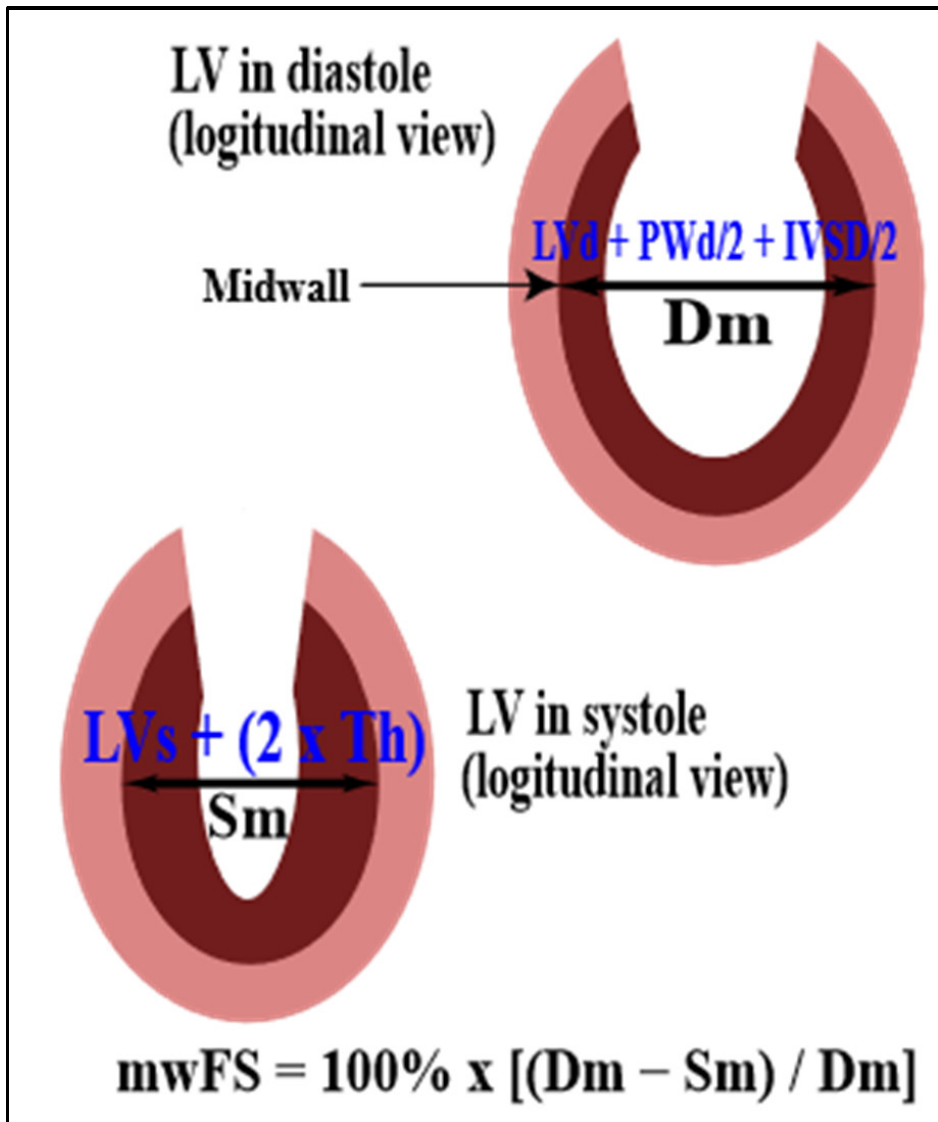
Figure 2. Calculation of LV midwall fractional shortening (mwFS) from LV end-diastolic diameter (Dm) and LV end-systolic diameter (Sm) at the midwall level. IVSD: interventricular septum end- diastolic thickness; LV: left ventricle; LVd: LV end-diastolic internal diameter; LVs: LV end-systolic internal diameter; PWd: end-diastolic LV posterior wall thickness; Th: end-systolic thickness of the LV inner myocardial shell (i.e., between the midwall and endocardium). In addition, mwFS was analyzed after adjustment for circumferential end-systolic LV midwall stress (cESS) which is directed along the same axis as systolic shortening of relationship between stress (an index of afterload) and shortening oriented in the same direction (Figure